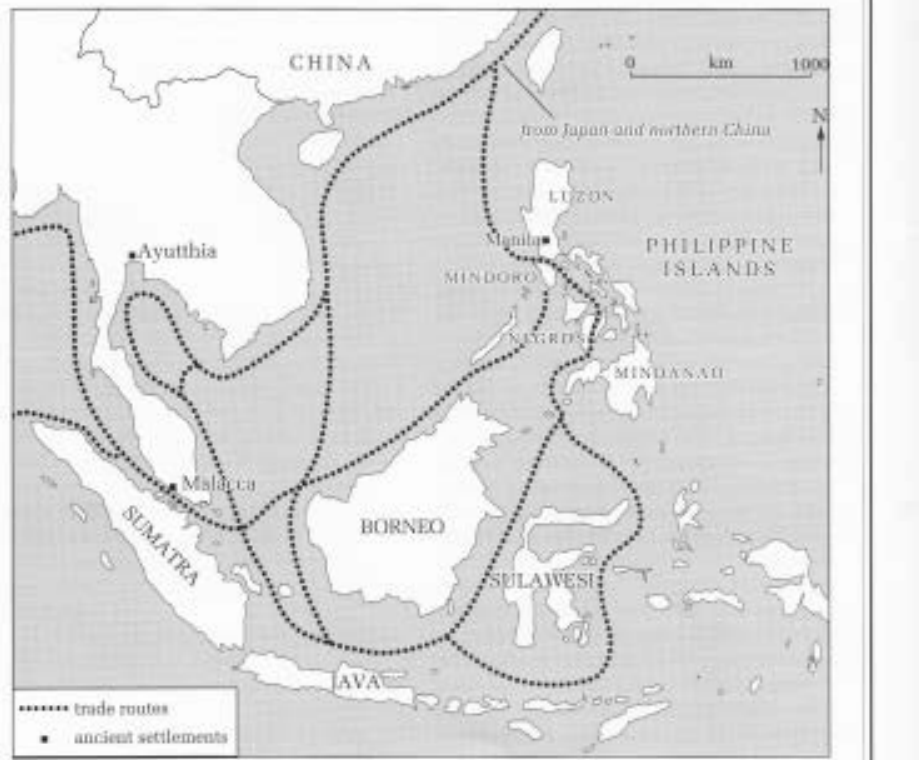
Figure 1 Southeast Asia, showing the location of the Philippine Archipelago, selected ancient settlements and late prehistoric trade